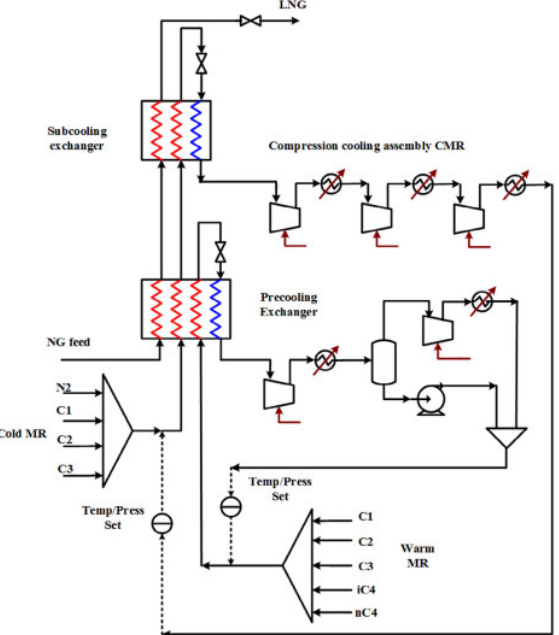
Figure 38. DMR natural gas liquefaction process [150]. Reproduced with permission from Elsevier (license number